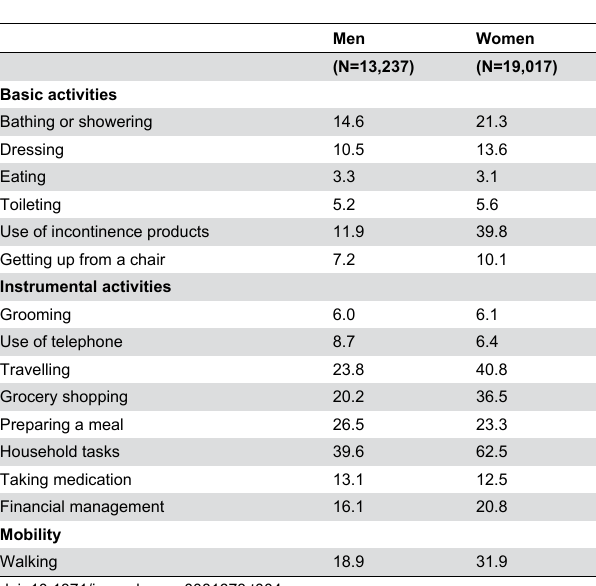
Table 4. Percentage of older persons requiring assistance for activities of daily living by sex, The Older Persons and Informal Caregivers Minimal DataSet, Netherlands, 2012.